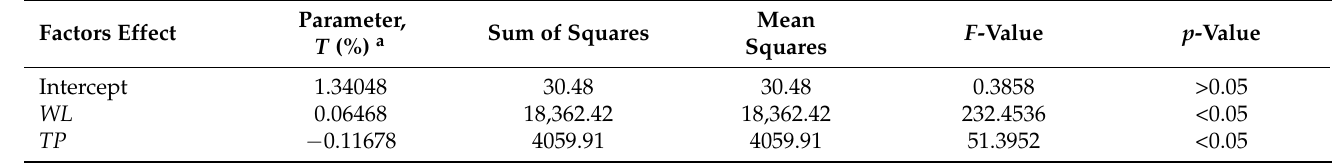
Table 9. Transmittance parameter estimates and statistical evaluation.